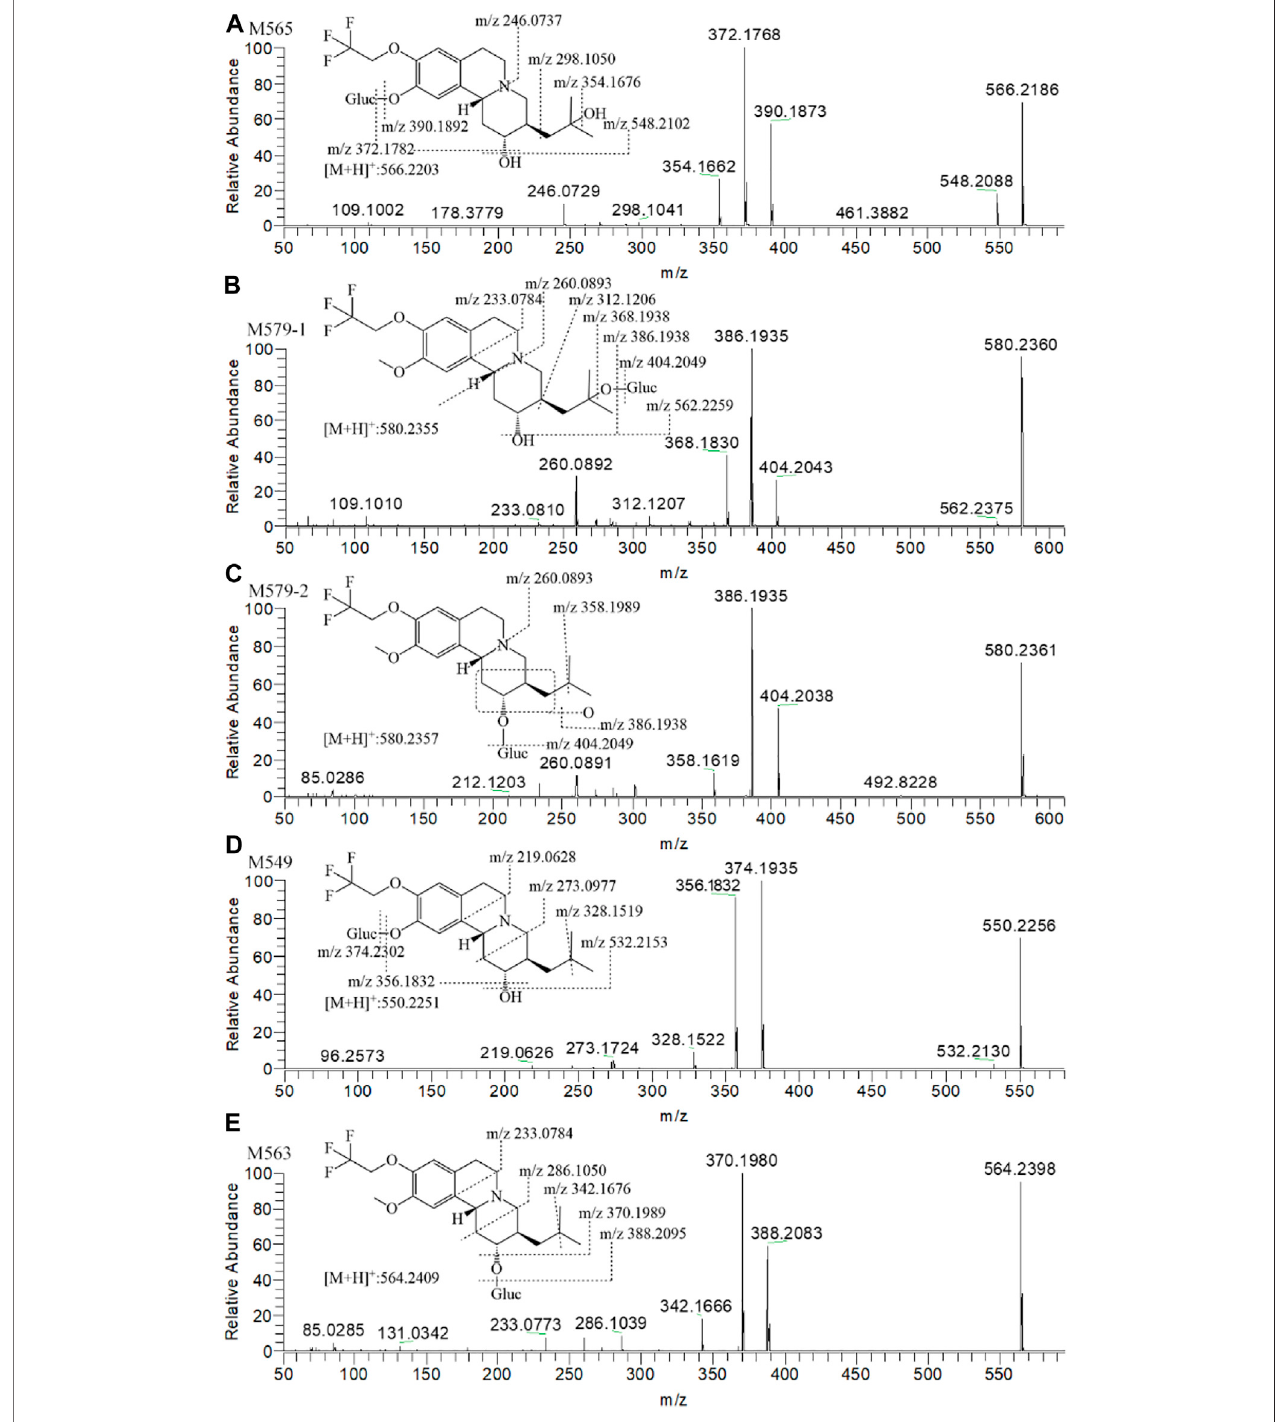
FIGURE 7 | The MS 2 spectra and proposed fragmentation pathways of (+)-9-tri fl uoroethoxy- α -dihydrotetrabenazine [(+)-13e] metabolites in dog plasma after a single oral dose at 3 μ mol/kg.